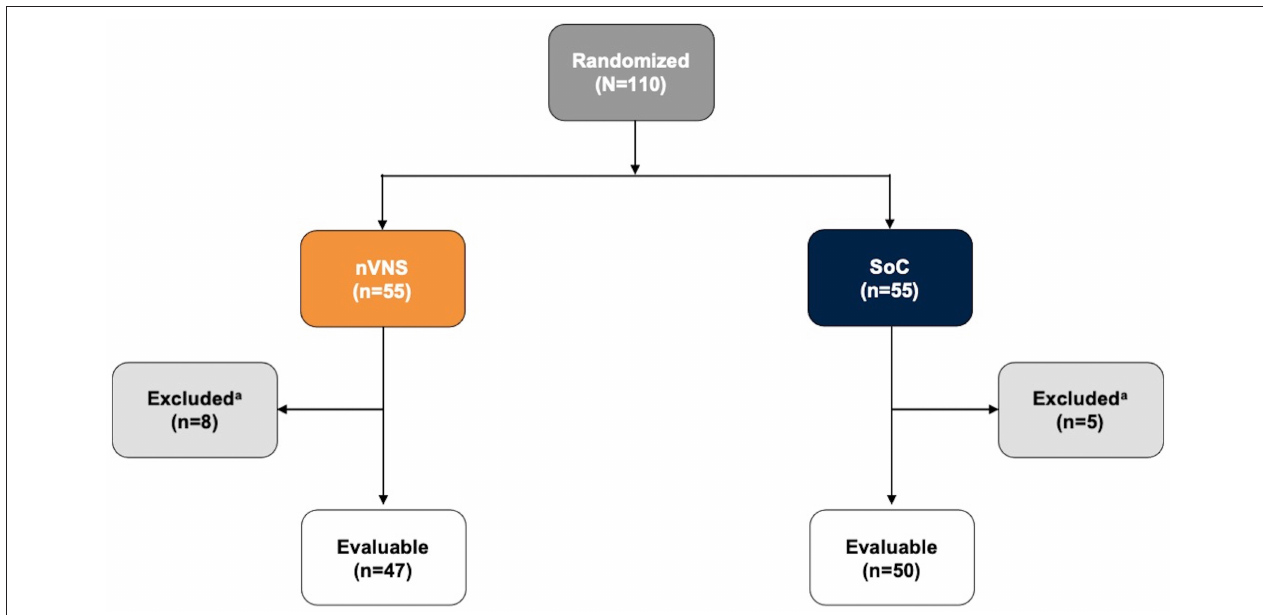
FIGURE 3 | Participant Disposition. a Excluded participants had missing baseline demographic and/or medical history data. nVNS, non-invasive vagus nerve stimulation; SoC, standard of